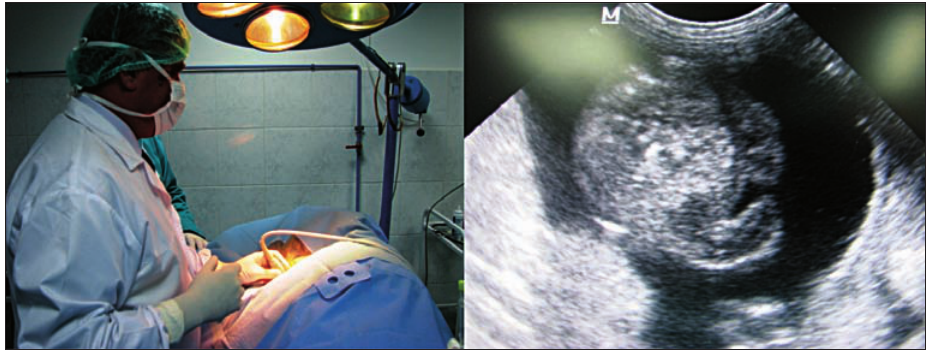
Fig. 1. Transabdominal ultrasound before in utero transplantation